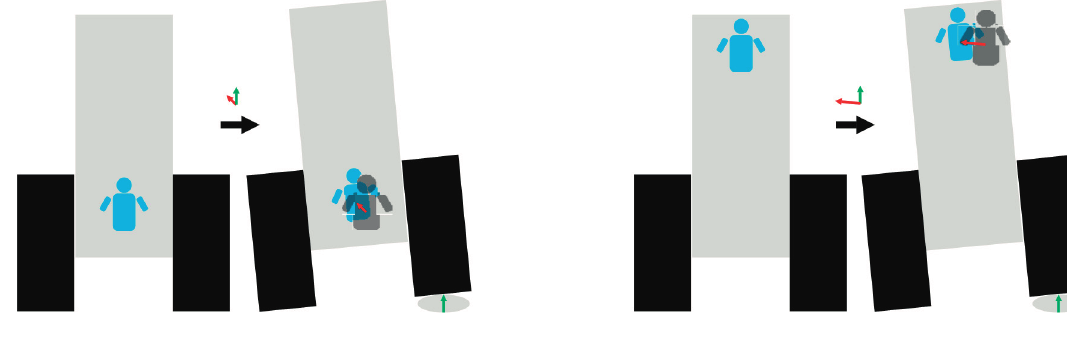
Figure 2. Diagram of a rear view of the tractor depicting the vibrations transmitted by uneven terrain when the tractor seat is in a low position ( left ) and when the tractor seat is in a high position ( right ). The red arrow represents the displacement of the driver caused by the displacement of one wheel of the tractor (green arrow), moving over uneven terrain. Note that the red arrow is smaller in the figure on the left than in the figure on the